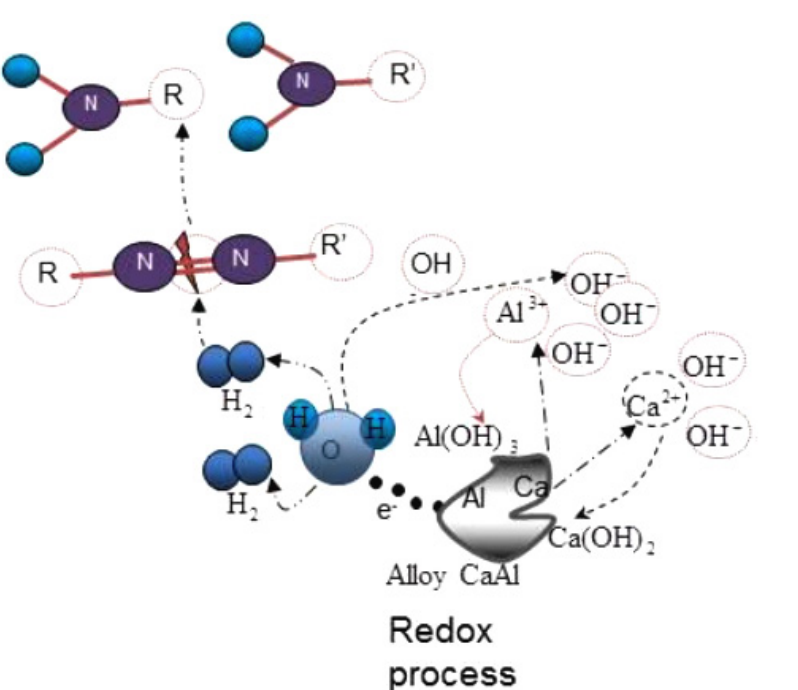
Figure 2. Schema of the proposed degradation mechanism of RB5 using Ca 65 Al 35 compound. Reprinted/adapted with permission from Ref. [23]. 2017, Elsevier.